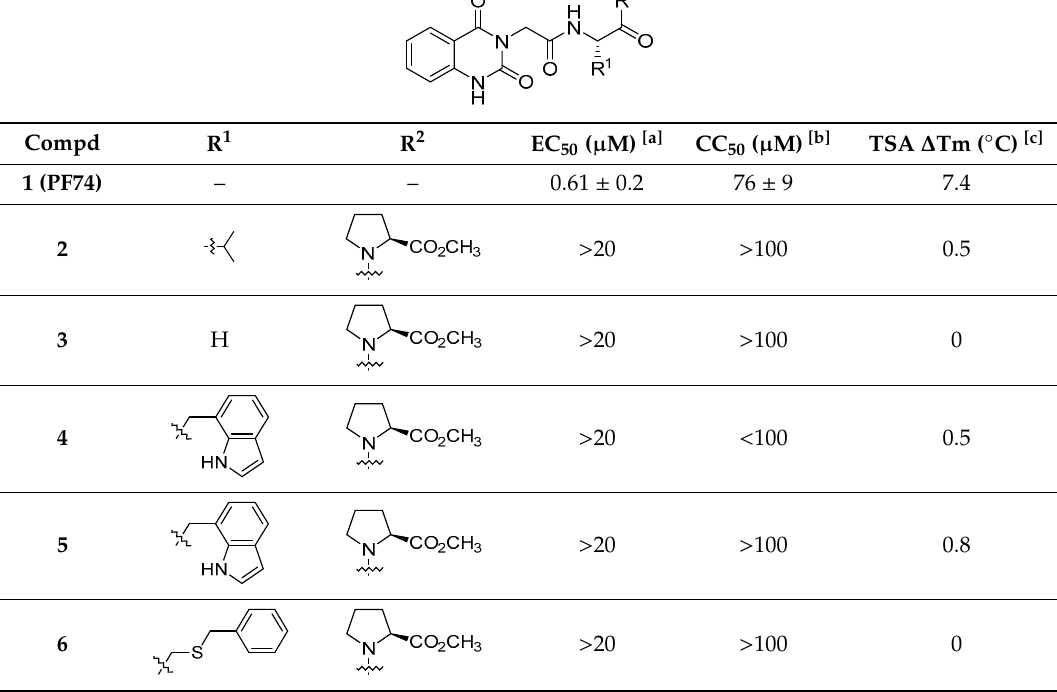
Table 1. Anti-HIV-1 activity, cytotoxicity, and CA hexamer stability profiles of 2 – 10 (R 1 , R 2 ).